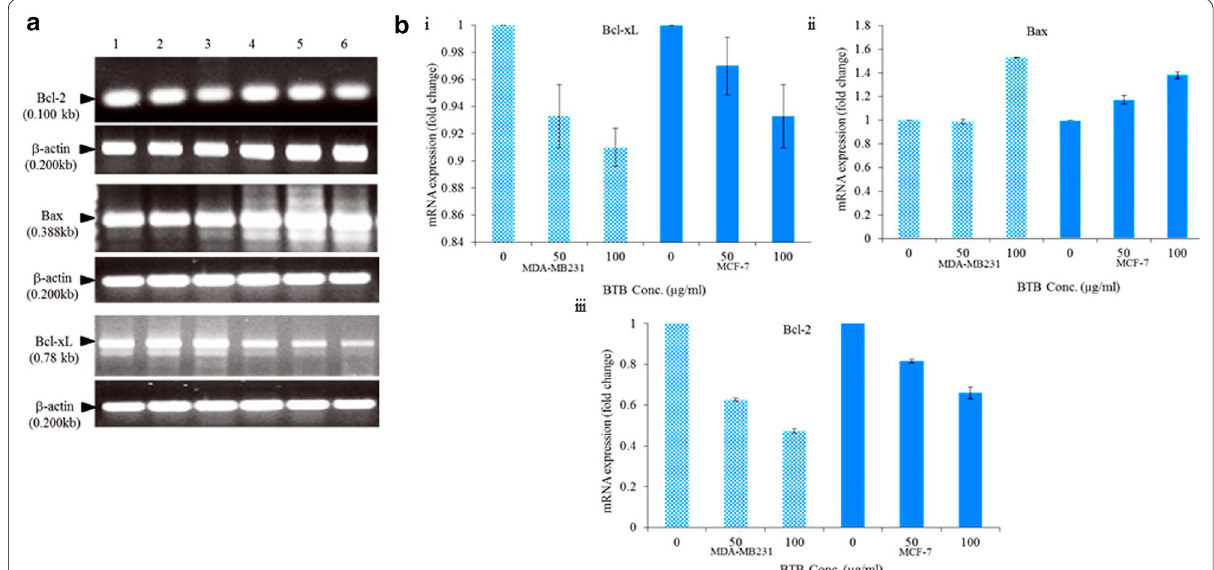
Fig. 8 Effect of BTB extracts on Bcl-2, Bax and Bcl-xL in MCF-7 and MDA-MB231 cells ( a ) on genes (mRNA) expression by PCR in MCF-7: lane 1 (untreated); lane 2 and 3 treated with 50 and 100 μg/ml respectively. MDA-MB231: lane 4 (untreated); lane 5 and 6 treated with 50 and 100 μg/ml respectively. b On mRNA expression by real time PCR of intrinsic apoptotic signalling molecules on cells; change in the expression of Bcl-xL ( i ) and Bax ( ii ) genes in both breast cancer cells in a dose dependent manner, ( iii ) Bcl-2 was decreased with the increasing concentration of BTB